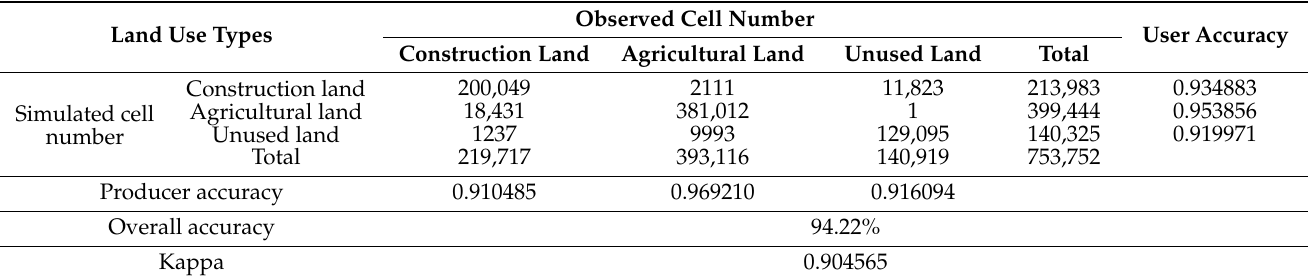
Table 5. The confusion matrix of observed and simulated land use types in 2018.